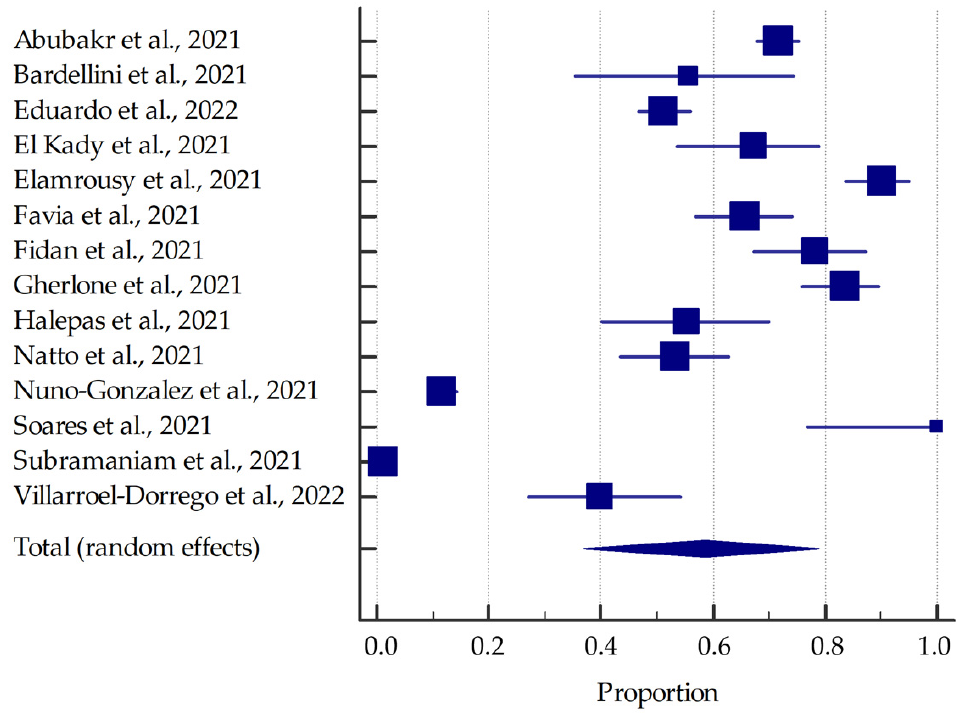
Figure 3. Forest plot presenting the summarised prevalence of oral manifestations among SARS-CoV-2 positive individuals.